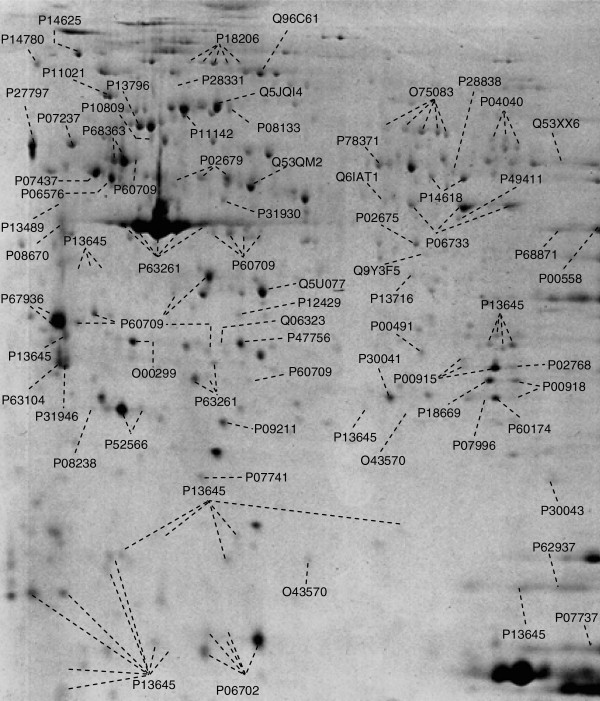
Protein mapping in circulating leucocytes of breast cancer patients; first-dimensional separation was performed in immobilised pH gradient (IPG) strips (Bio-Rad, USA) in the range of IP 4–7. Following first-dimensional separation, the extruded IPG-strips were equilibrated in gel equilibration buffer I (50 mM Tris–HCl, 6 M urea, 30% glycerol, 2% SDS, 1% DTT), followed by equilibration in buffer II (50 mM Tris–HCl, 6 M urea, 30% glycerol, 2% SDS and 260 mM iodacetamide) for 10 min before loading them onto polyacrylamide gels (12% SDS-PAGE) for the second-dimensional resolution in Mini-PROTEAN 3 (Bio-Rad). Altogether, 74 proteins were consequently identified by MALDI-TOF analysis; data taken from [11].